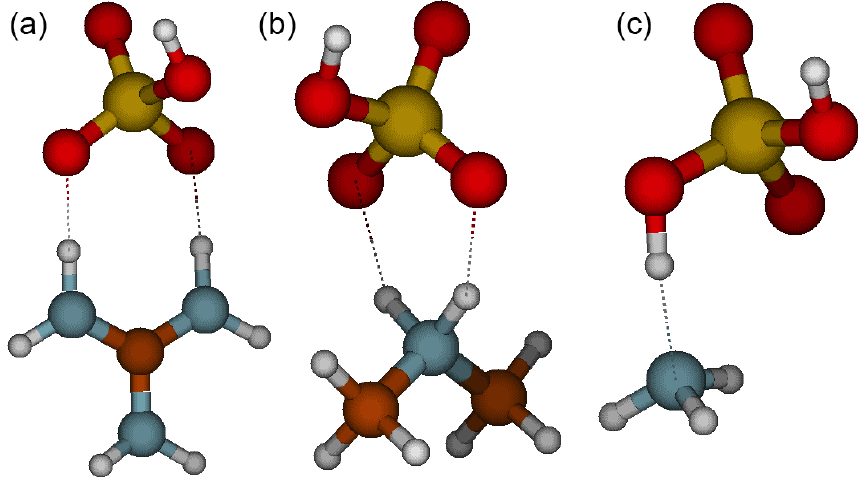
Figure 1. Molecular structures of sulfuric acid heterodimers with guanidine (a) , dimethylamine (b) and ammonia (c) . Color coding: brown is carbon, blue is nitrogen, red is oxygen, yellow is sulfur and white is hydrogen.